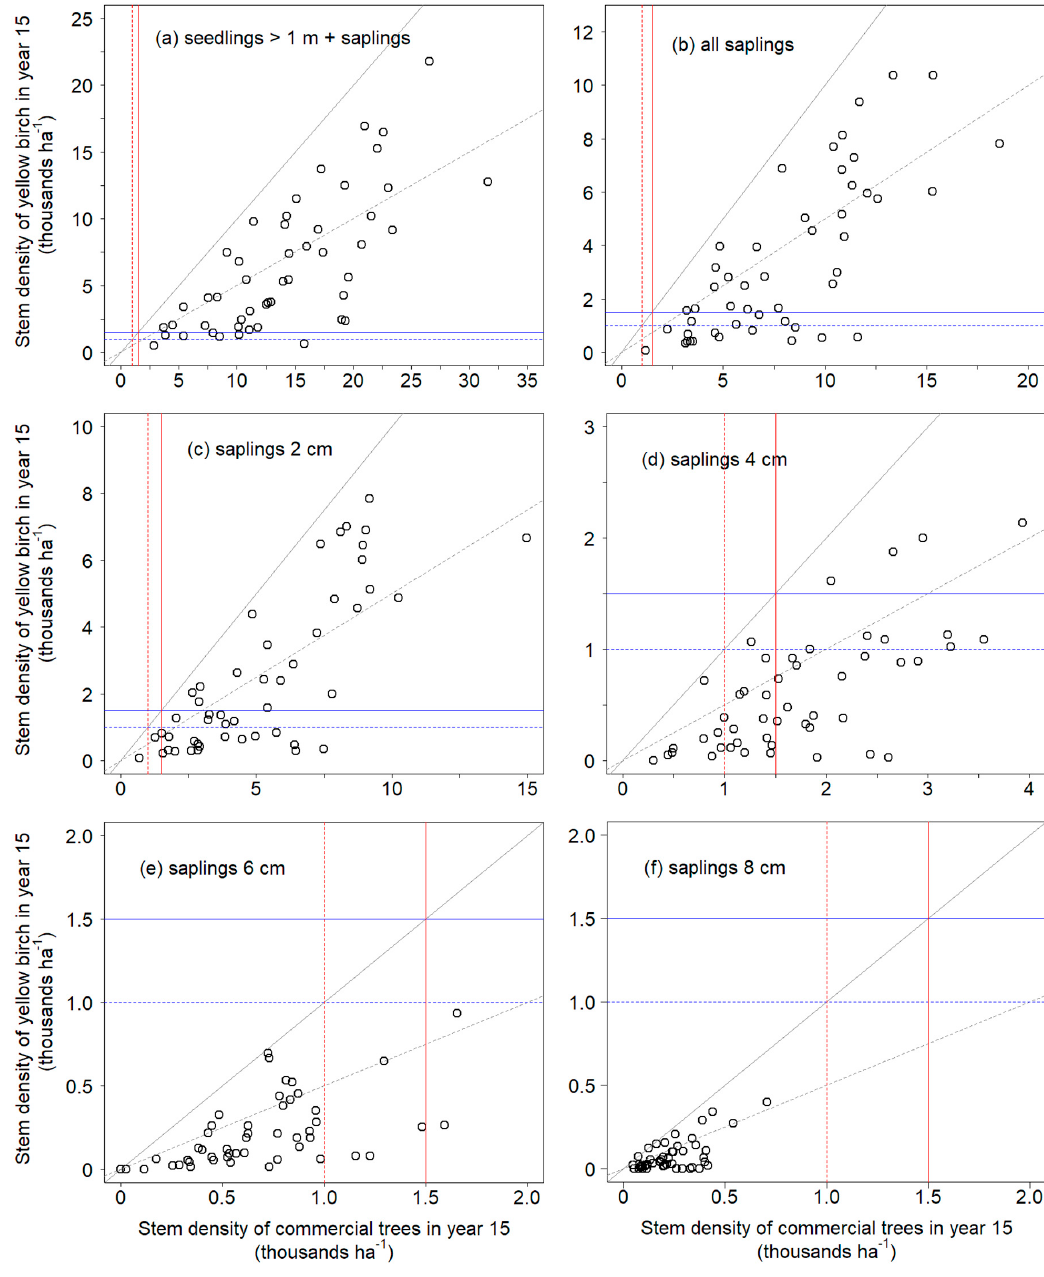
Figure 5. Relationship between stem density of yellow birch and stem density of all commercial tree species 15 years after harvest within canopy openings created by group selection and patch cutting. Data points are cluster means, presented for different developmental stages: ( a ) seedlings at least 1 m in height and saplings, ( b ) all saplings, and ( c – f ) saplings further distinguished by their diameter at breast height (DBH, in cm). Note the change in scales. Solid grey line is the 1:1 relationship and dashed grey line is the 1:0.5 relationship. Blue horizontal and red vertical lines represent the 1000 (dashed) and 1500 (solid) stems ha − 1 thresholds based on Leak et al. 1987.